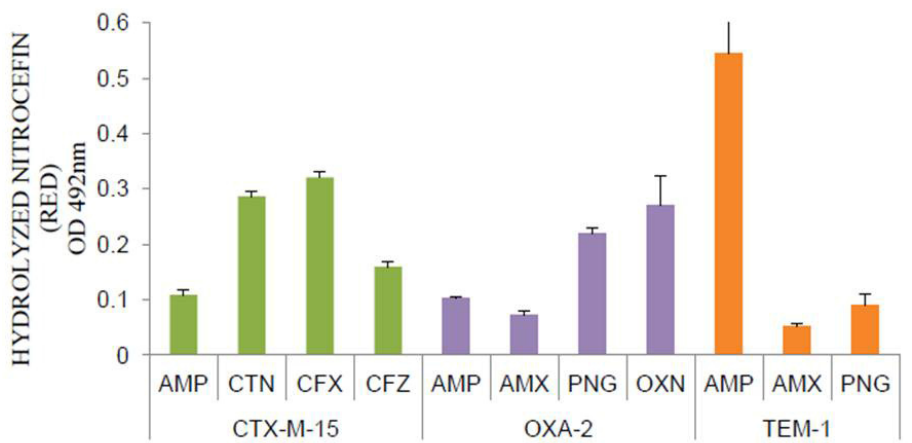
Figure 1. Induction of serine beta-lactamases—CTX-M-15, OXA-2 and TEM-1 by beta-lactam anti-